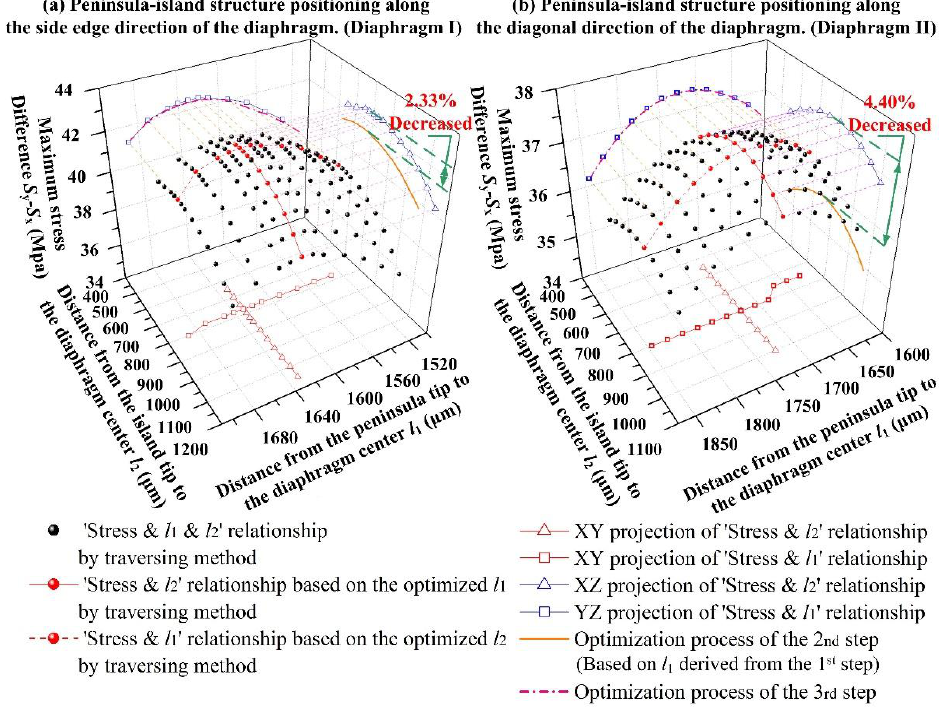
Figure 12. The relationship between stress difference ( σ = S y − S x ) and l 1 for two diaphragm structures. Based on the second step, by relocating the SCR position in the third step, the stress difference and optimized values of l 1 and l 2 agreed well with the results of the transversing method. The